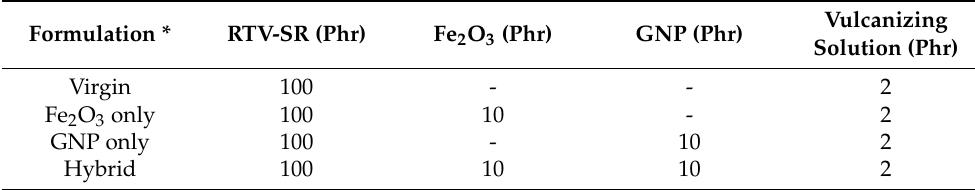
Table 1. The filler–rubber mixing lasted for 10 min. Next, 2 phr of vulcanizing agent was added and mixed for 1 min. The composite was poured into the molds and kept at room temperature for vulcanization for 24 h before removal for testing. Table 1. Formulation table of the RTV-SR based composites. Formulation